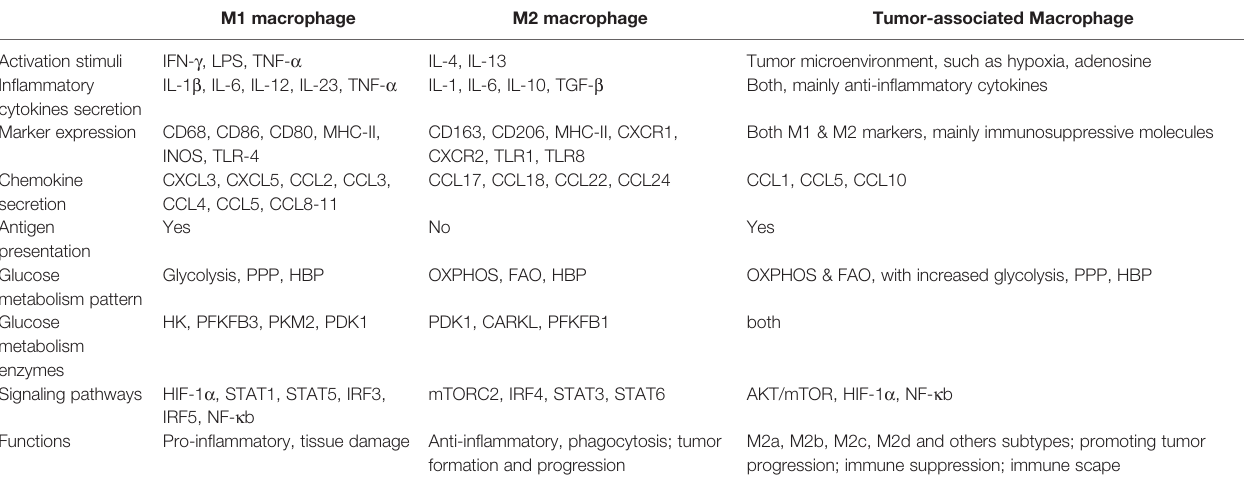
TABLE 1 | The complexity between macrophage phenotypes and glucose